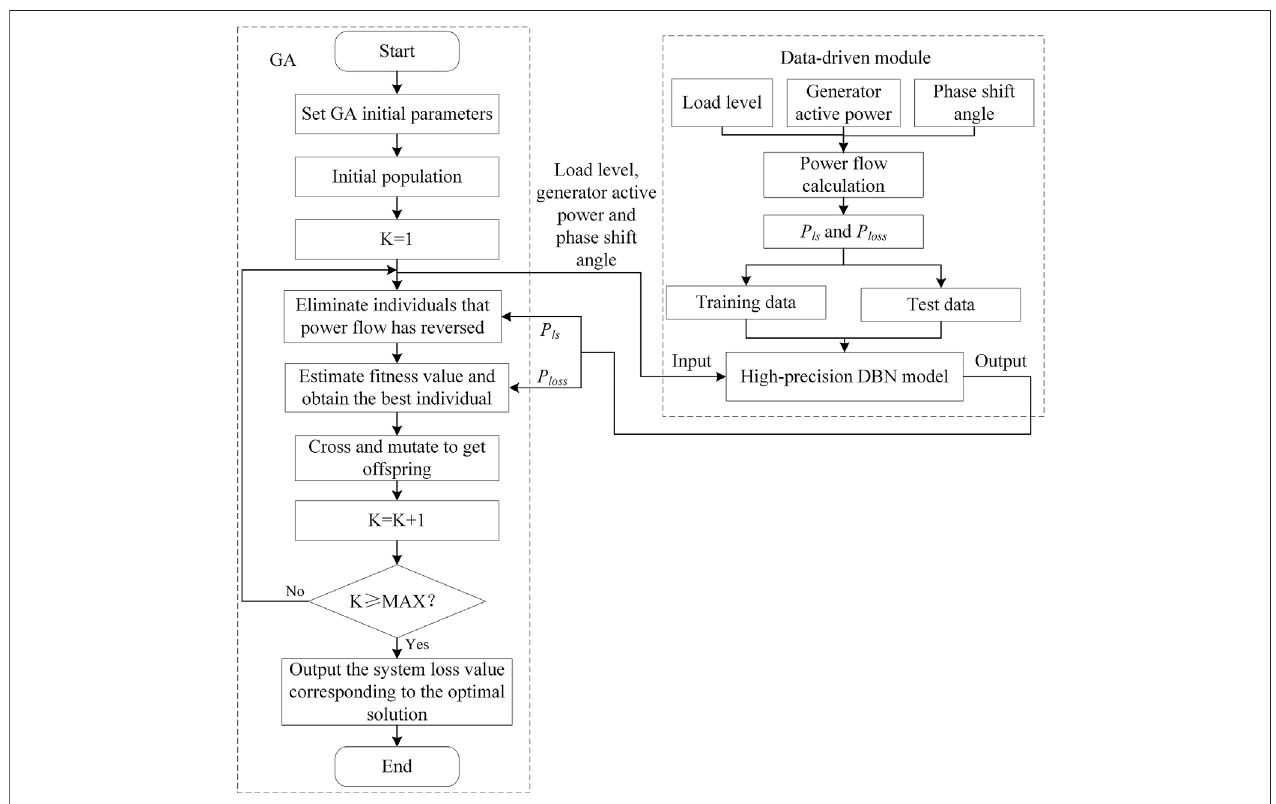
FIGURE 5 | The fl ow chart of improved genetic algorithm based on data